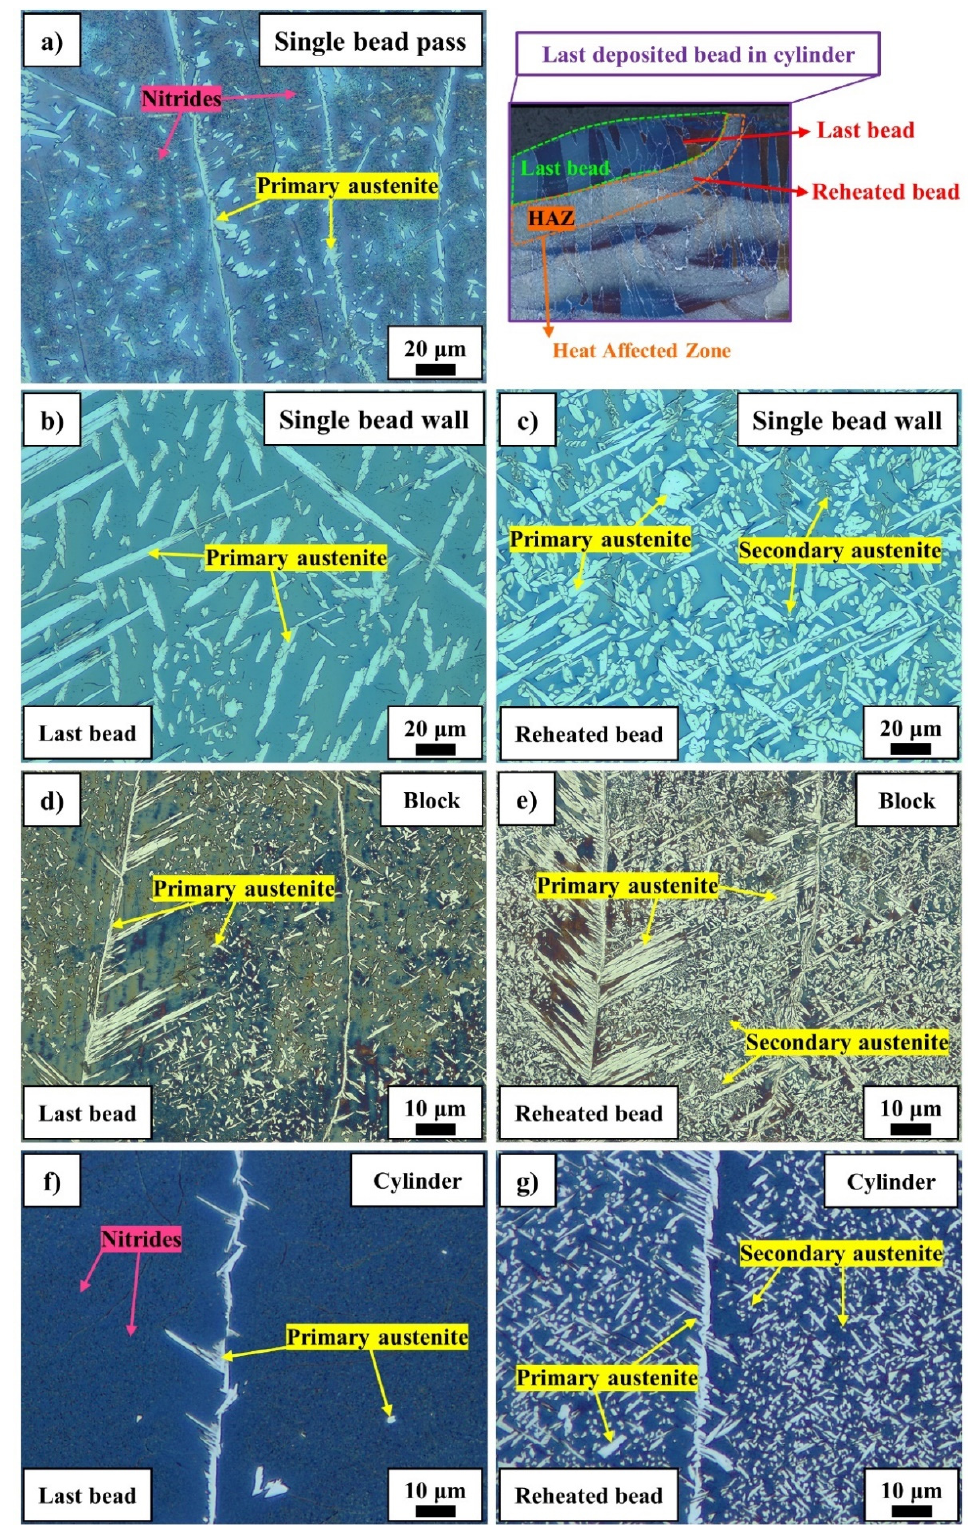
Figure 6. Light optical microscopy of LMDw components. The microstructures of a single-bead pass and of last deposited and underlying beads in a single-bead wall, block, and cylinder. Samples were etched with modified Beraha, showing ferrite as the dark and austenite as the bright phase. Growth of primary austenite and formation of secondary austenite are seen in the reheated beads.